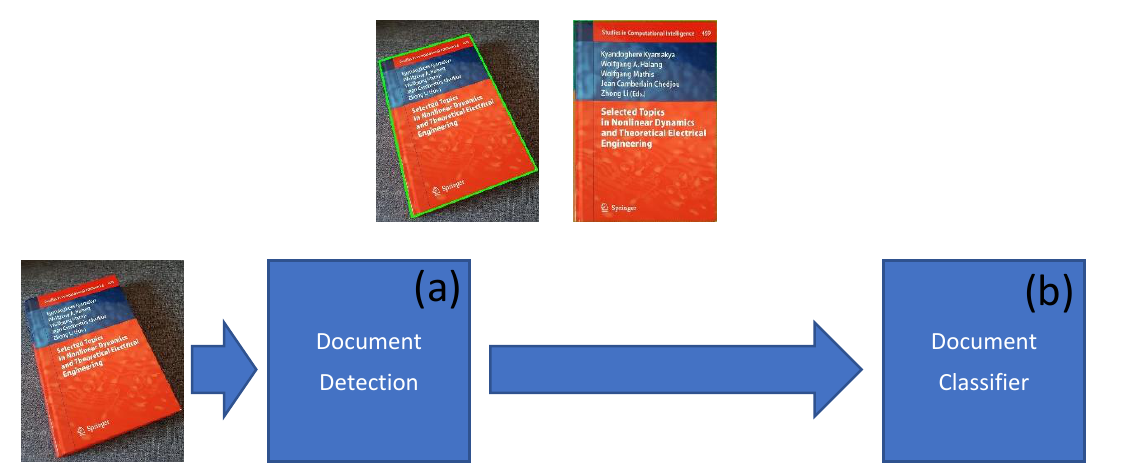
Figure 3. The novel global model is composed of two modules: ( a ) a Document Detection; and ( b ) a Document Classifier (Source: our own images).